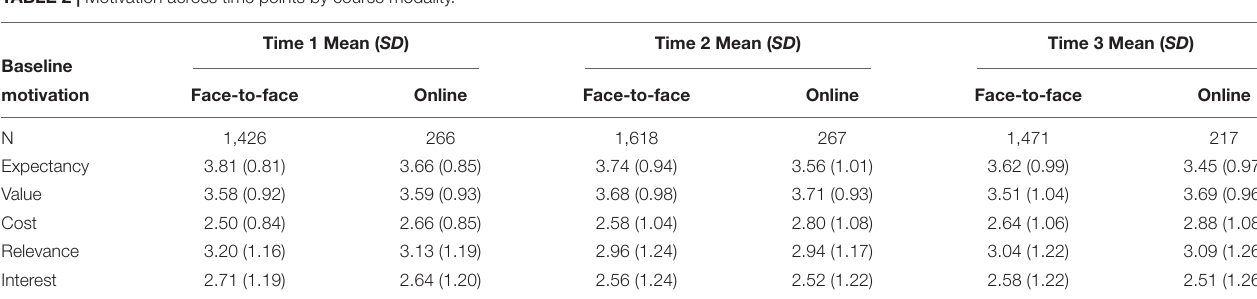
TABLE 2 | Motivation across time points by course